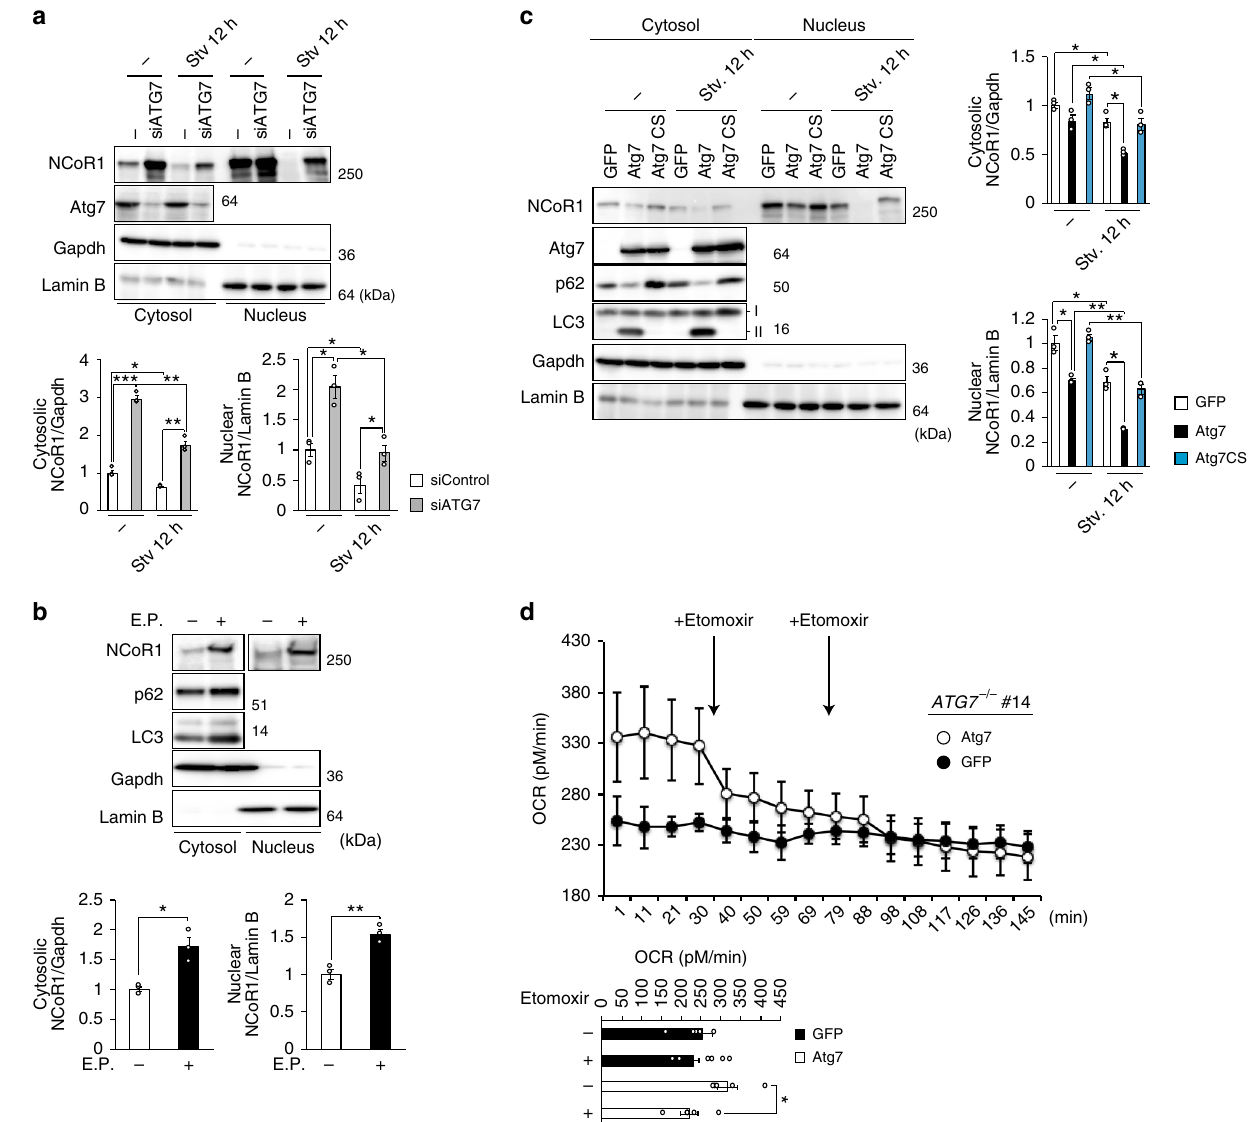
Fig. 6 Degradation of NCoR1 in autophagy-lysosomal pathway. a Immunoblot analysis. Both nuclear and cytoplasmic fractions were prepared from ATG7 - knockdown HepG2 cells under nutrient-rich and deprived conditions and subjected to immunoblotting with the indicated antibodies. Data are representative of three separate experiments. Bar graphs indicate the quantitative densitometric analyses of cytoplasmic and nuclear NCoR1 relative to Gapdh and Lamin B, respectively. b Immunoblot analysis. HepG2 cells were cultured in the presence or absence of E64d and Pepstatin A (E.P.) for 24 h. Subsequently, both nuclear and cytoplasmic fractions were prepared from the HepG2 cells and subjected to immunoblotting with the indicated antibodies. Data are representative of three separate experiments. Bar graphs indicate the quantitative densitometric analyses of cytoplasmic and nuclear NCoR1 relative to Gapdh and Lamin B, respectively. c Immunoblot analysis. GFP, wild-type ATG7, or ATG7 C572S was expressed in ATG7 -knockout HepG2 (#14) cells by adenovirus system. Forty-eight hours after infection, the cells were cultured under nutrient-rich or -deprived conditions. Thereafter, both nuclear and cytoplasmic fractions were prepared and subjected to immunoblotting with the indicated antibodies. Data shown are representative of three separate experiments. Bar graphs indicate the quantitative densitometric analyses of cytoplasmic and nuclear NCoR1 relative to Gapdh and Lamin B, respectively.